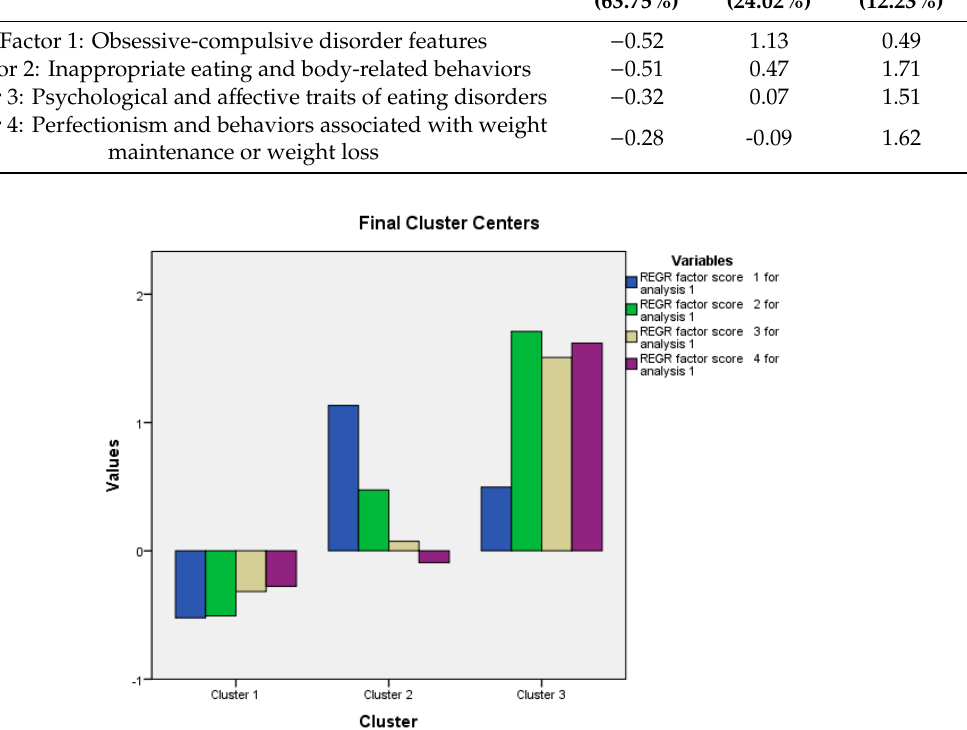
Figure1. Illustrationoffourfactorsinthethreeprofilesdefinedintheclusteranalysis. REGR:Regression. Figure 1. Illustration of four factors in the three profiles defined in the cluster analysis. REGR: Regression. Table 4. Bivariate analysis of factors associated with the DOS categories.